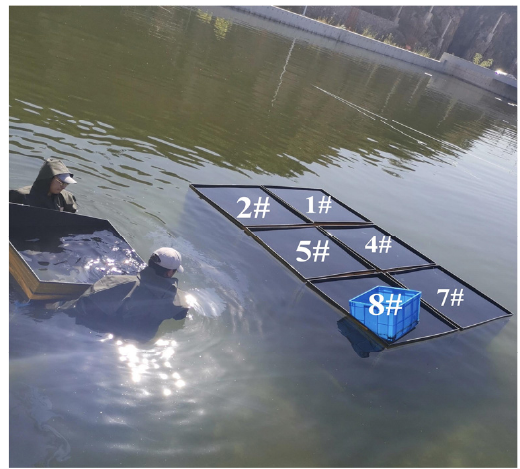
Figure 3. Installation of the PVC